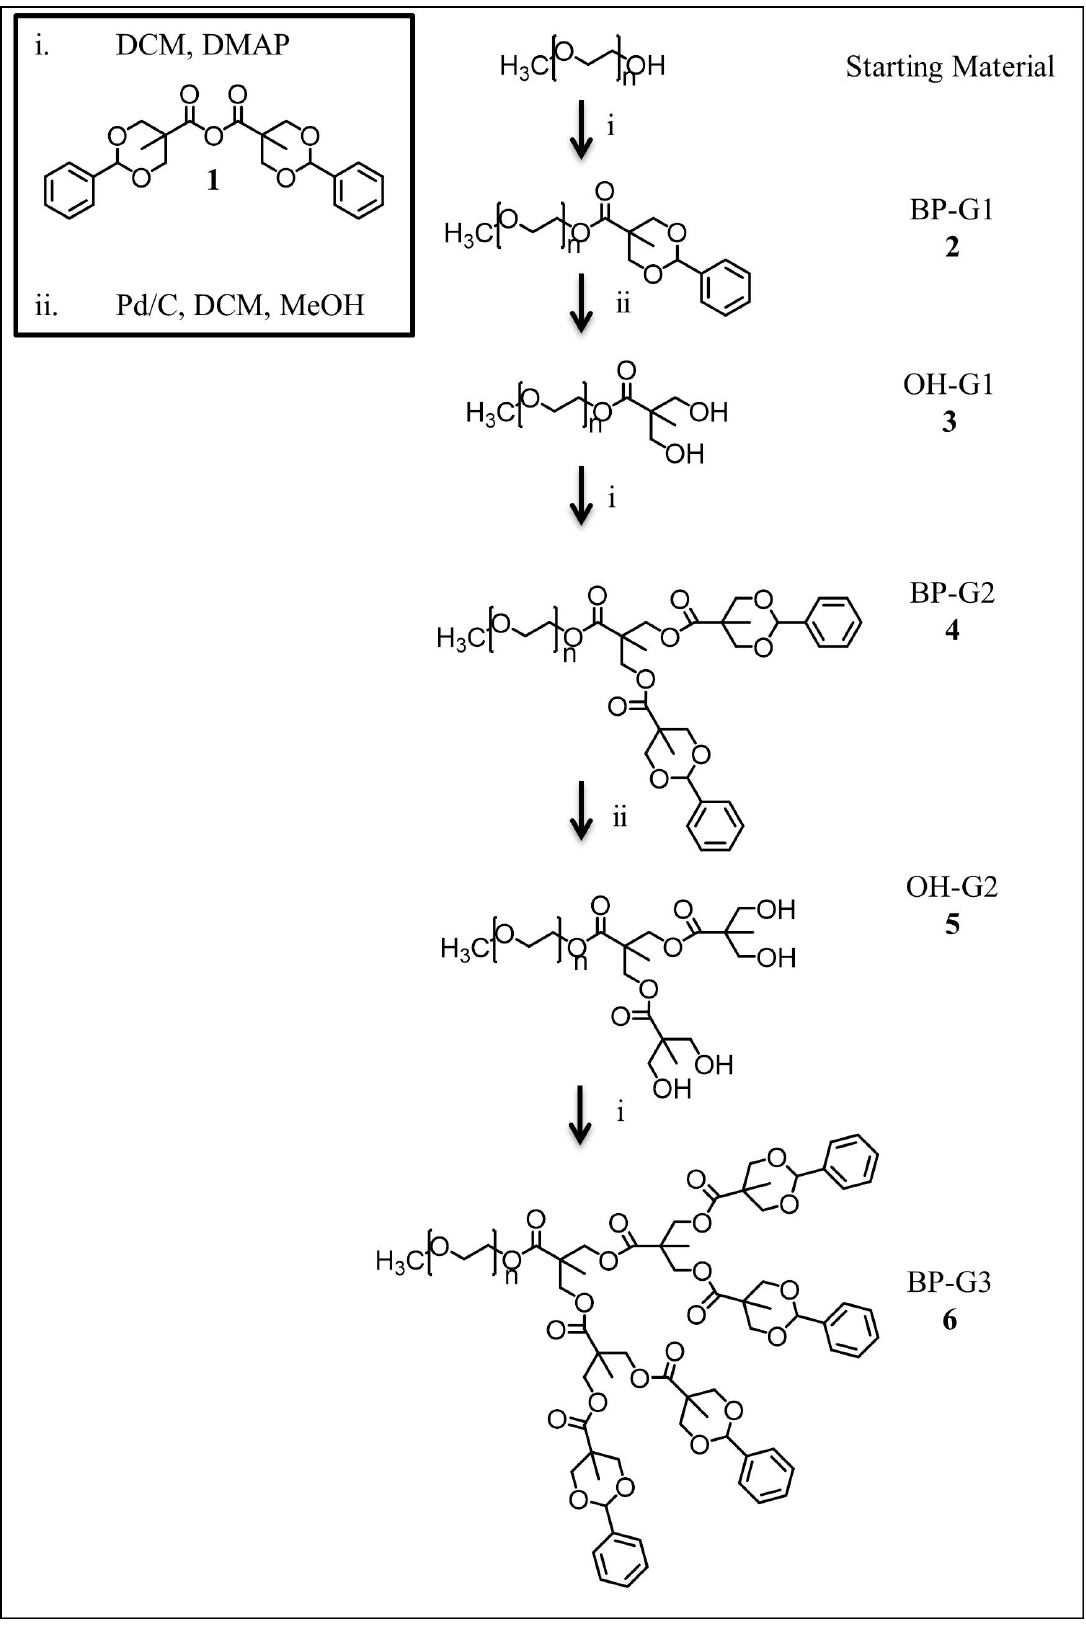
FIGURE 1 - Synthesis of linear-dendritic diblock via divergent dendronization of monomethyl ether PEG